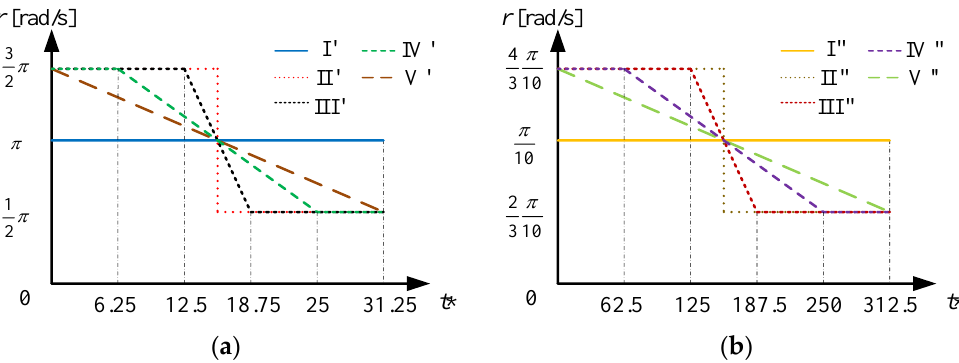
Figure 9. Schematic diagram of the relationship between speed and time in different valve closing laws: ( a ) closing time t * = 31.25. ( b ) closing time t * = 312.5.